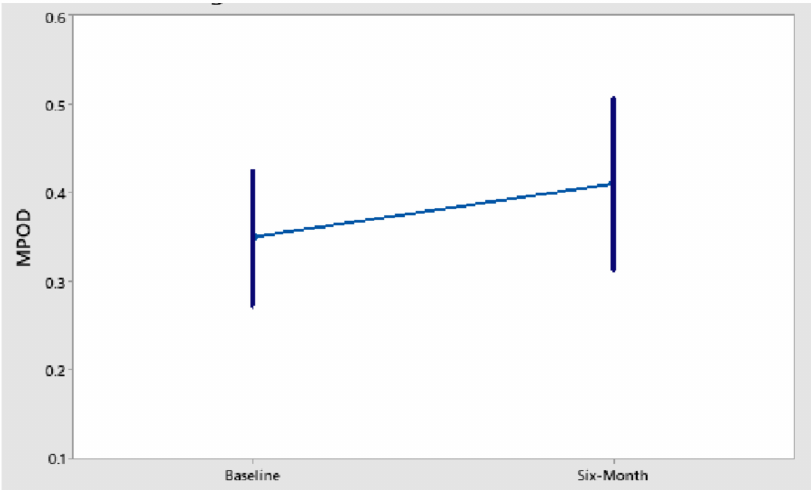
Figure 1. Mean MPOD with 95% confidence interval for baseline and 6-month